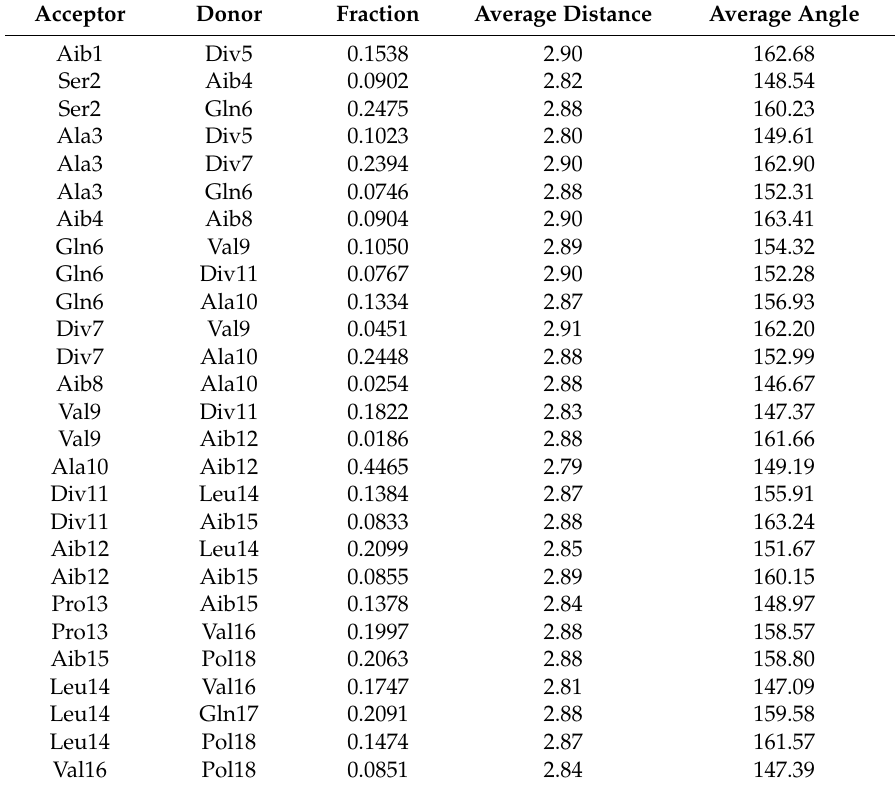
Table 3. Backbone H-bonds of TPN XIIc in explicit chloroform solvent along with their frequency of occurrence given by fraction, average distance, and